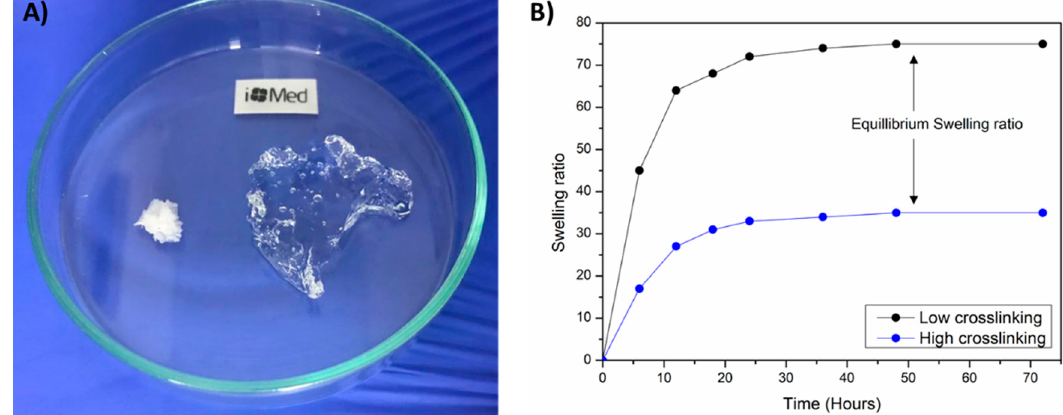
Figure 4. ( A ) Swelling ability of hydrogels from lyophilized state and ( B ) equilibrium swelling ratio determination.